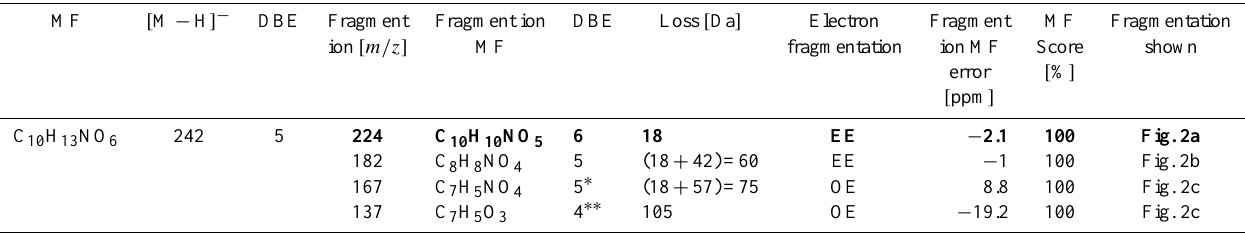
Table 3. Deprotonated molecular species fragmentation for compound 1, obtained from the use of the HPLC-ITMS 2 and the HPLC-QTOFMS 2 .